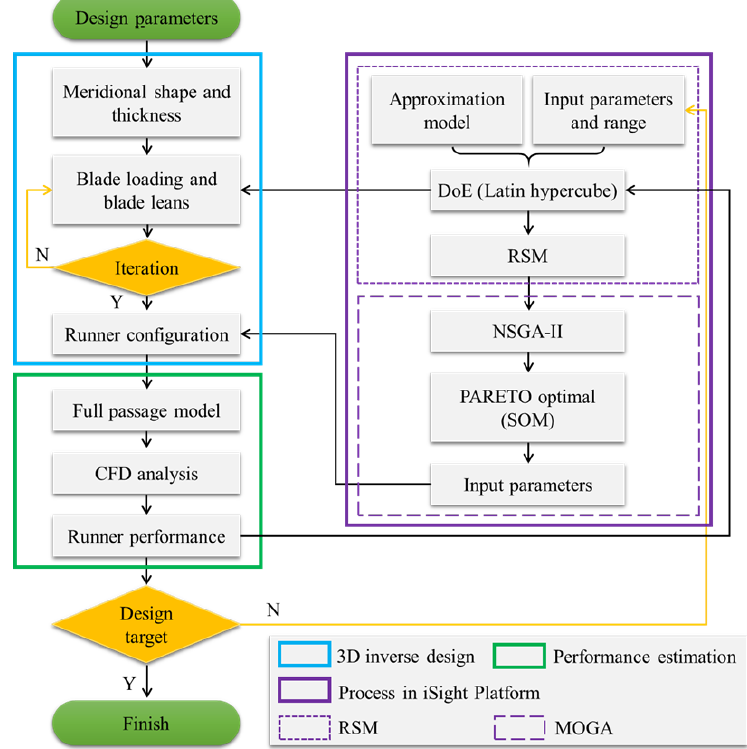
Figure 4. Flow chart of the optimization strategy.